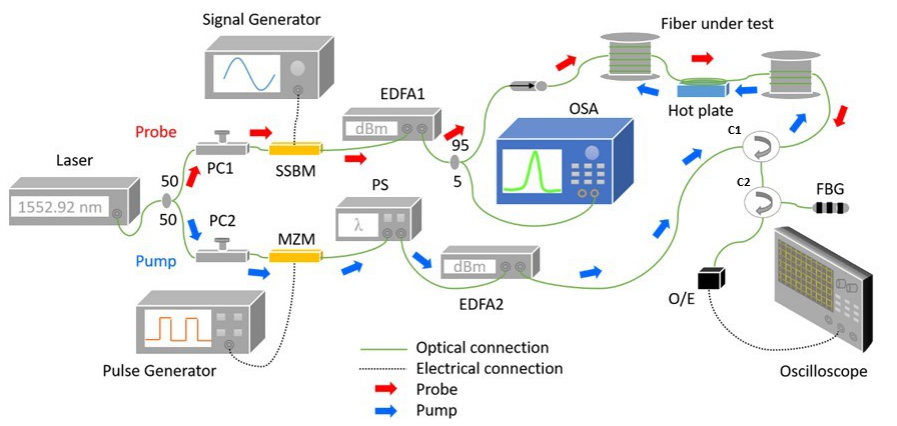
Figure 5. Experimental BOTDA